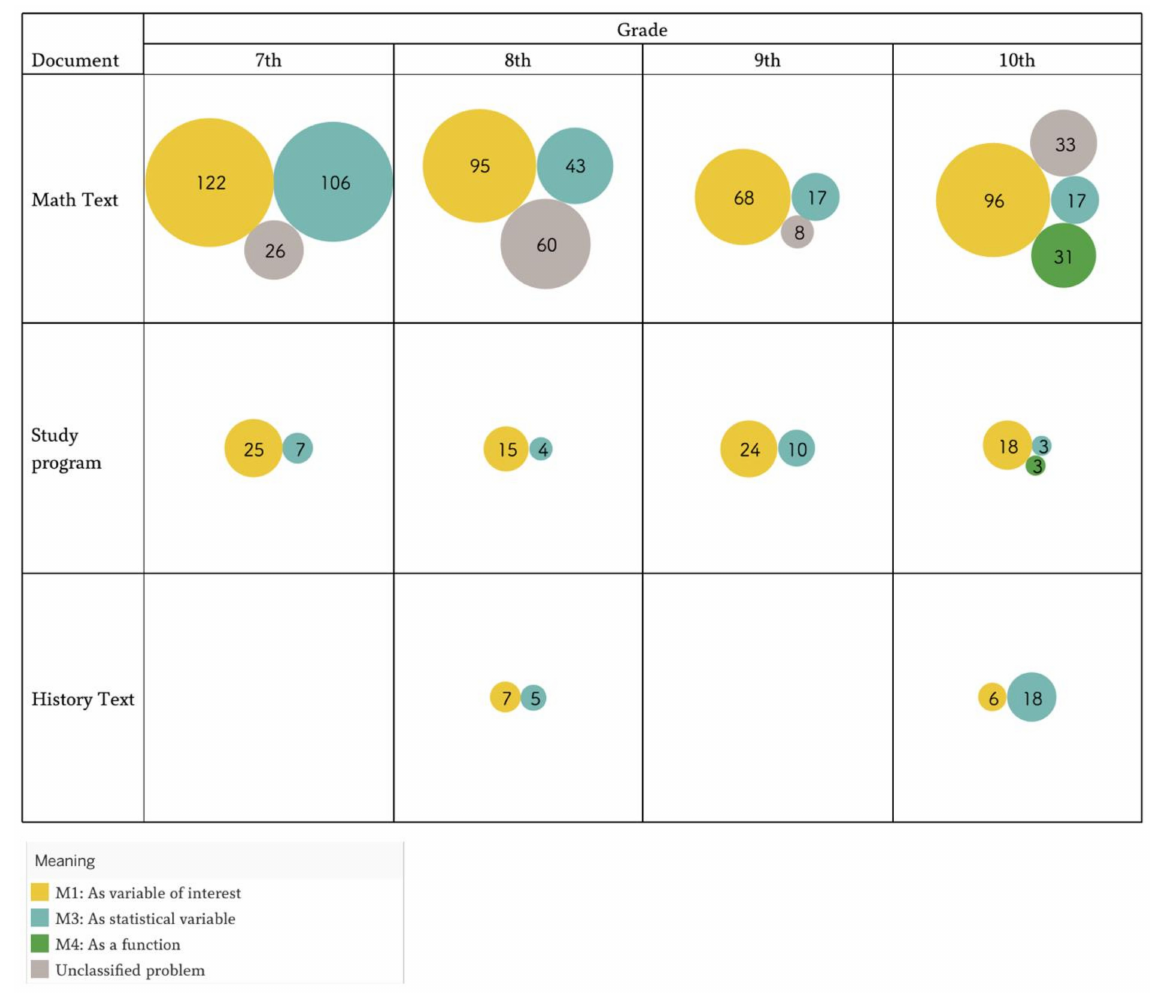
Figure 9. Presence of meanings by the level of education (Source: Prepared by the